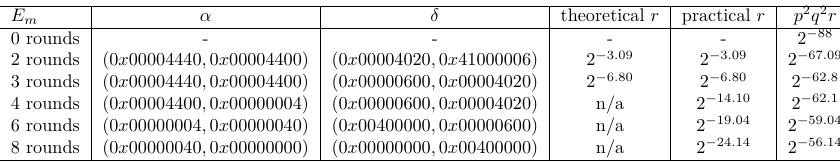
Table 4: Theoretical and practical values of r for various sizes of E m and corresponding probability of the 16-round distinguisher when applying the p 2 q 2 r formula. We detail the theoretical computation for 3 rounds in Appendix